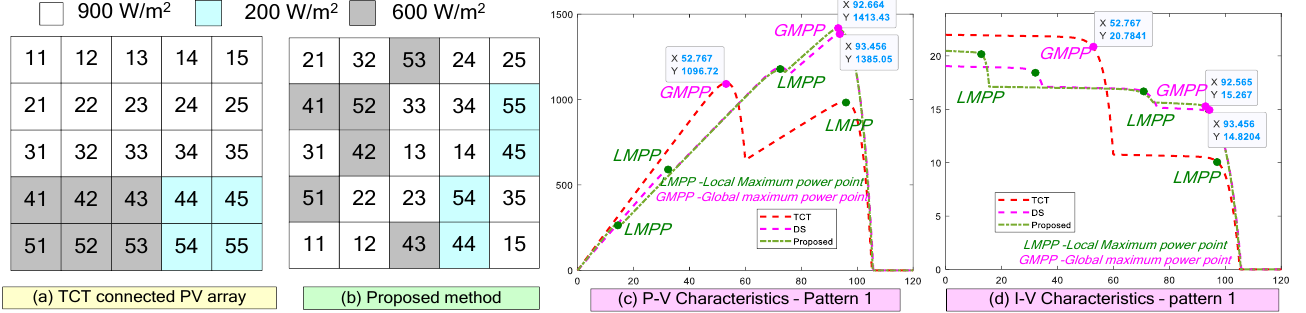
Figure 3. Shade pattern 1: ( a ) TCT arrangement, ( b ) Proposed arrangement, ( c ) P – V characteristics, ( d ) I – V characteristics. For shade pattern 2, a simple short, narrow shade pattern is considered. Similar to shade pattern 1, three various irradiations were considered (900 W/m 2 , 500 W/m 2 , and 600 W/m 2 ). In this shade case, only four panels were shaded in the 5 × 5 PV array. In the shade pattern for TCT, the rightmost corner is shaded, as shown in Figure 4a. In the TCT shade case, only two current changes are seen, whereas the proposed shade dispersion pattern has three row current changes with a negligible difference. A graphical representation of the dispersed 5 × 5 PV array is shown in Figure 4b. Acknowledging the row current changes with TCT and the proposed method, the I – V and P – V characteristics are plotted in Figure 4c,d, respectively, producing a global power of 1661.33 W and 1755.3 W. Despite the DS model producing global power (1691 W) closer to V oc , the proposed scheme has obtained a higher power, showing the potential of the proposed method.